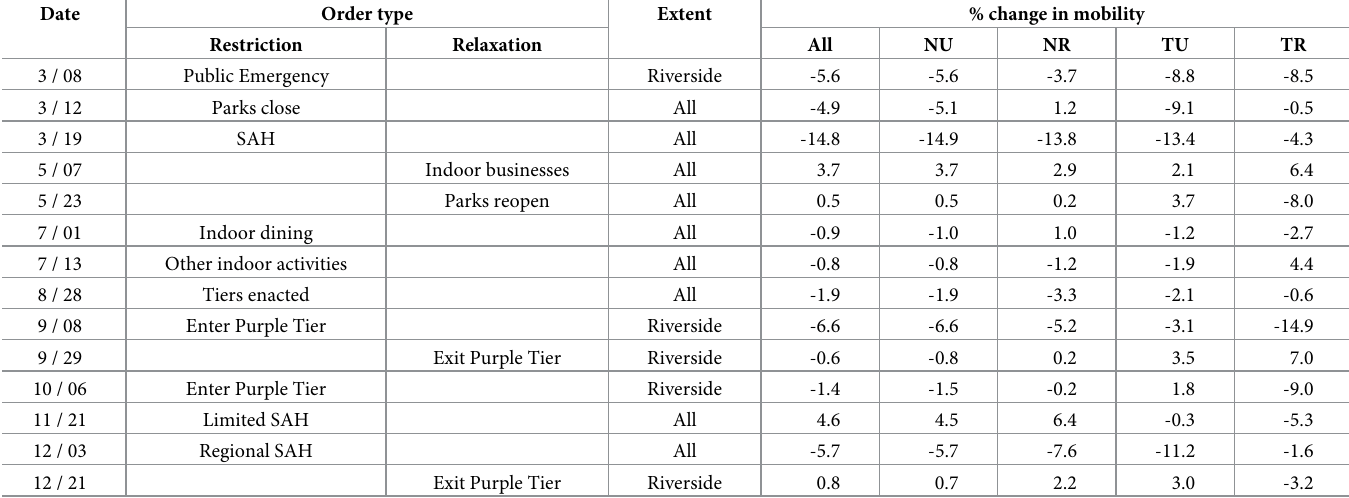
Table 4. Events expected to influence